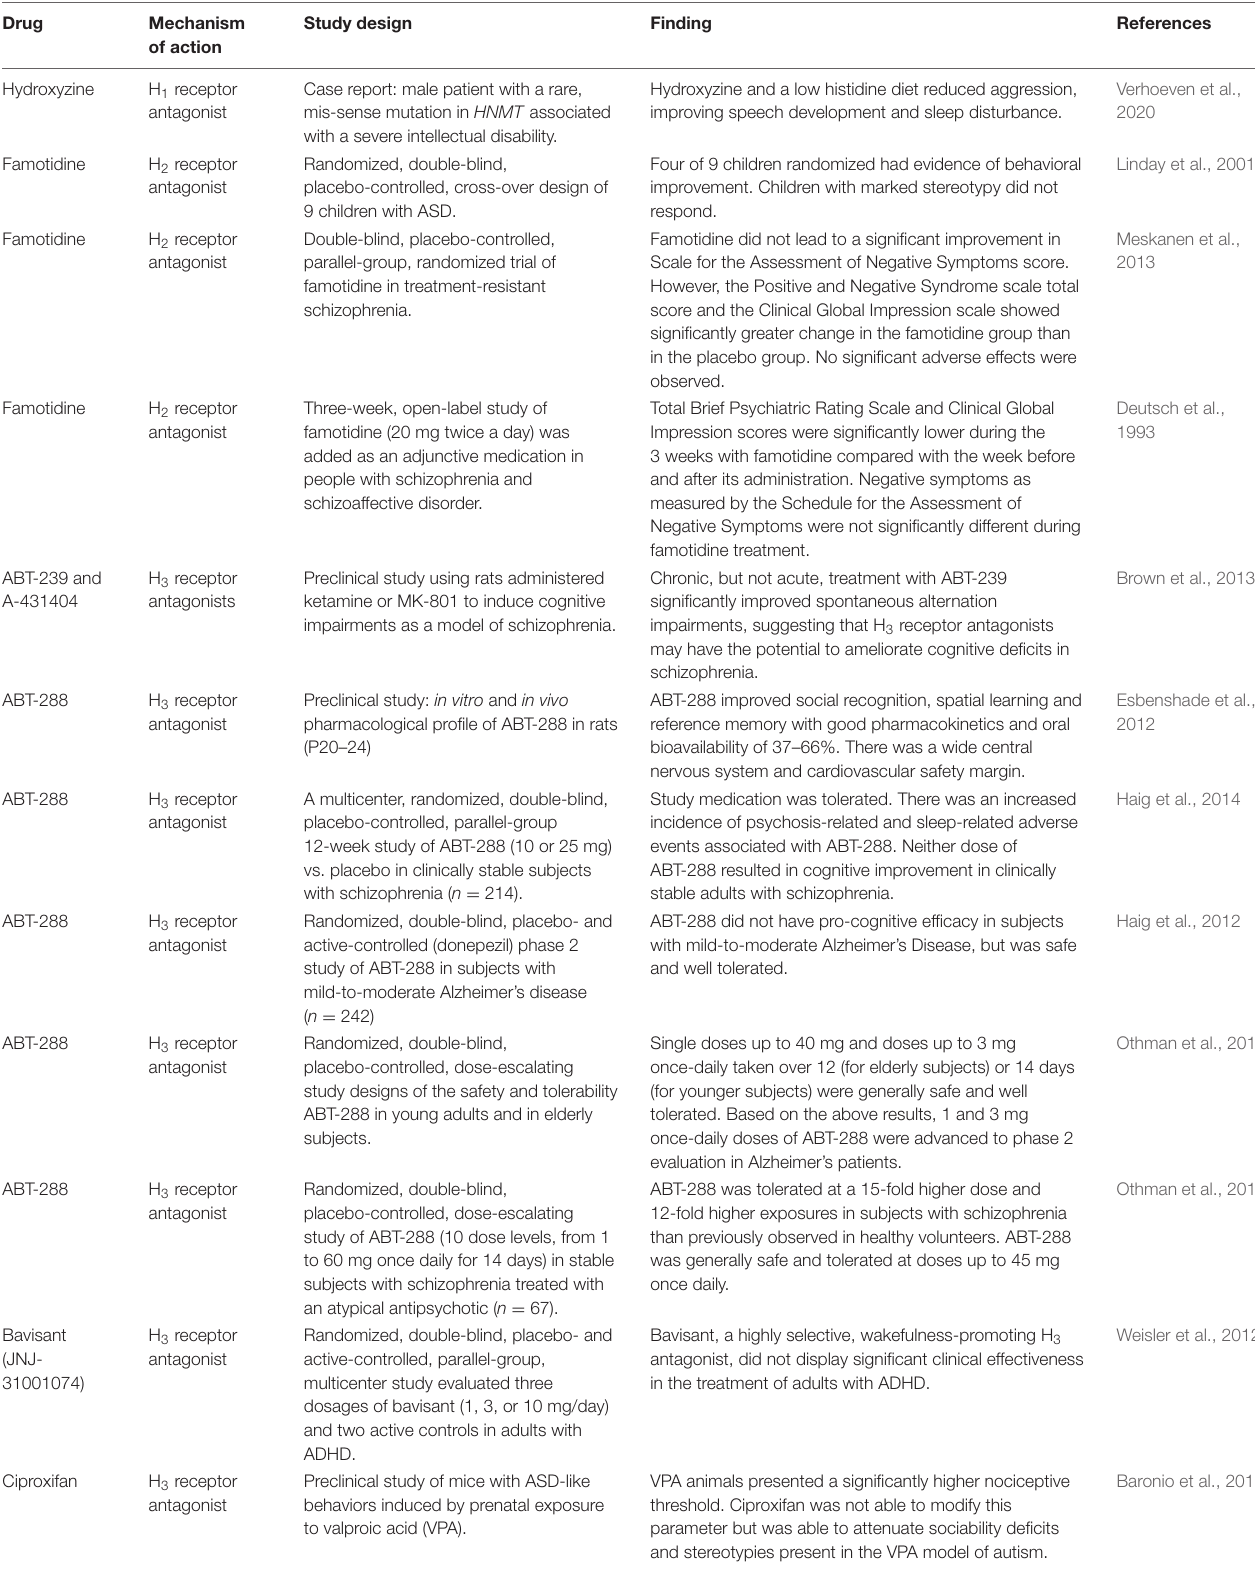
TABLE 3 | Summary of preclinical and clinical studies of histamine receptor modulators in neuropsychiatric